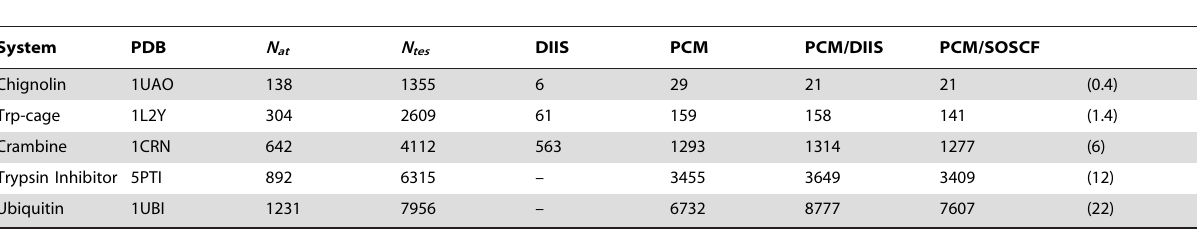
Table 5. Absolute timings for energy and gradient